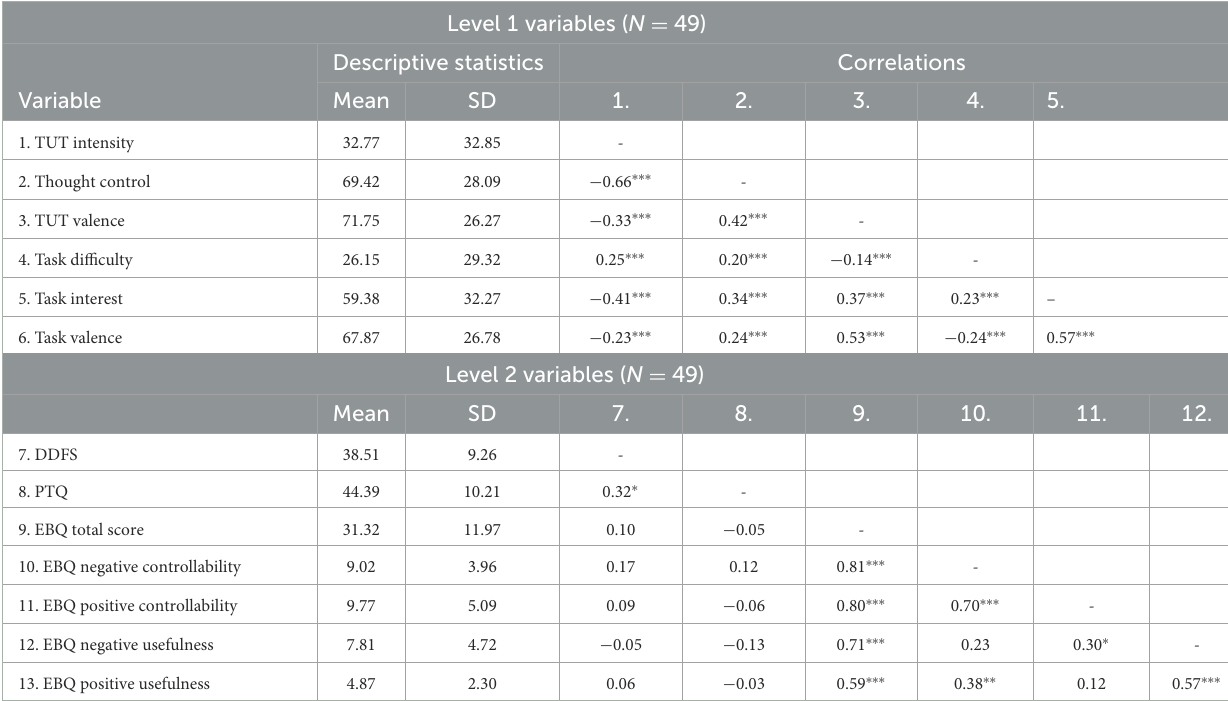
TABLE 1 Descriptive statistics and correlations of level 1 and 2 variables.